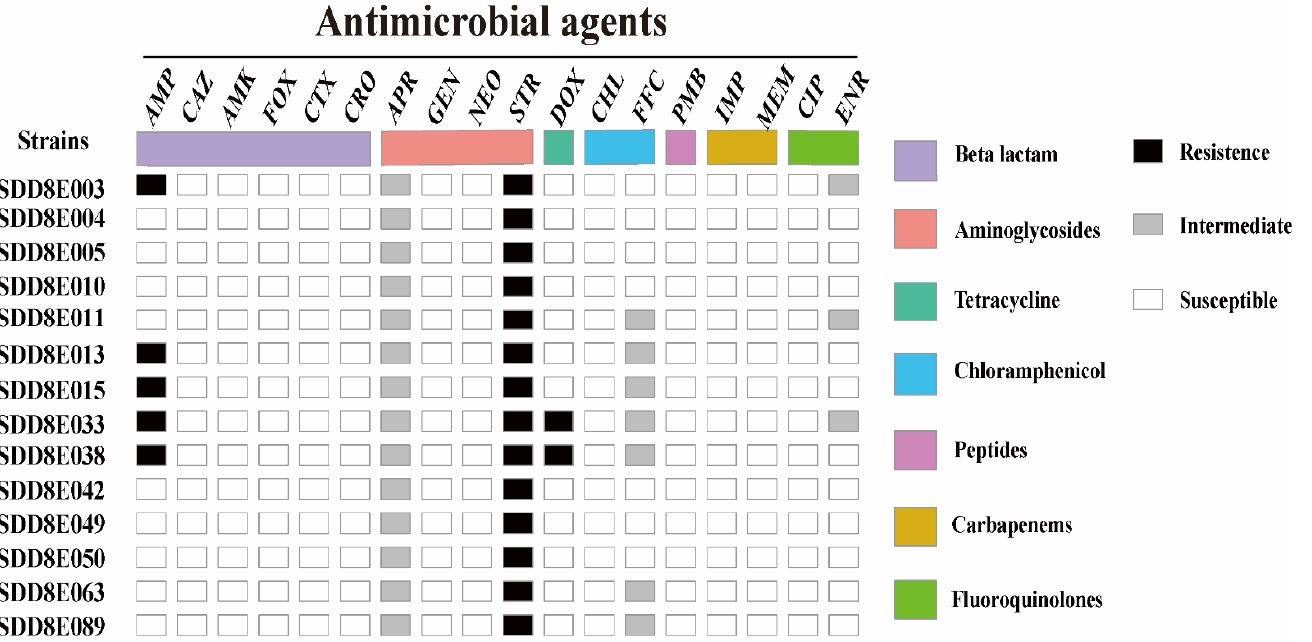
Figure 3. Susceptibility of all Salmonella isolates to 18 antibiotics.